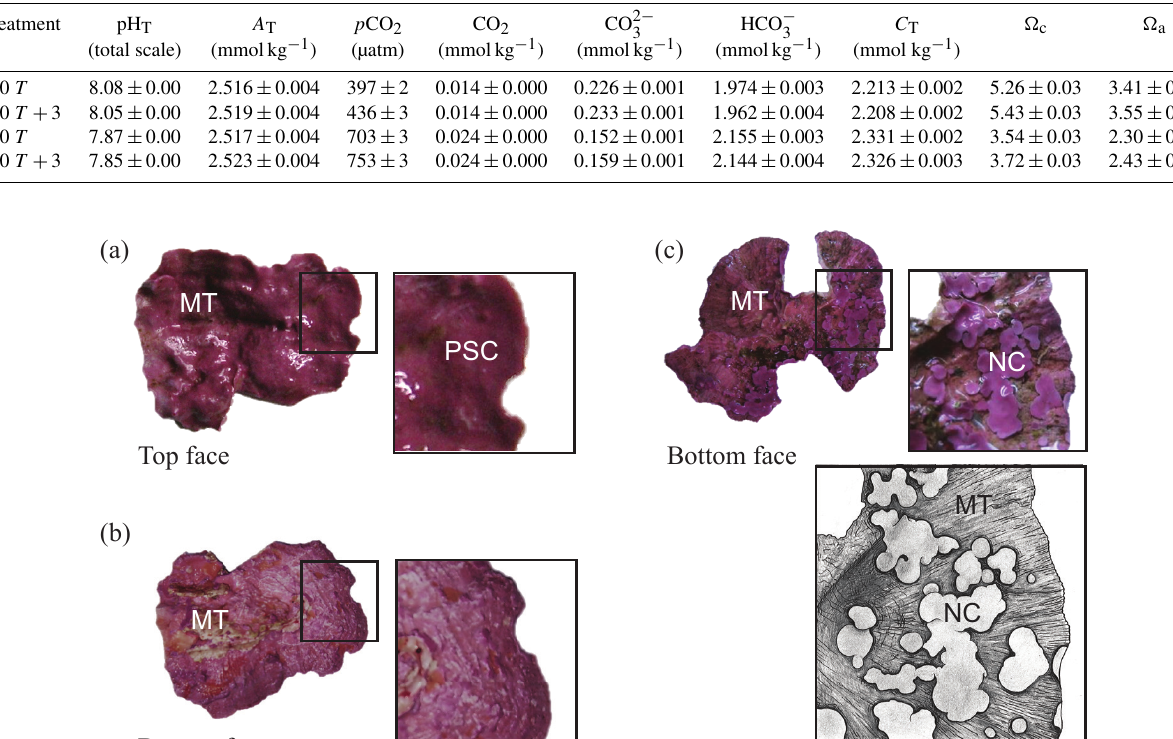
Figure 1. (a) Top face of the main thallus (MT) of L. cabiochae showing the pink surficial crust (PSC) and bottom faces (b) free of crusts at the time of collection and (c) with new crusts grown during the experimental period (photos and drawing by S.